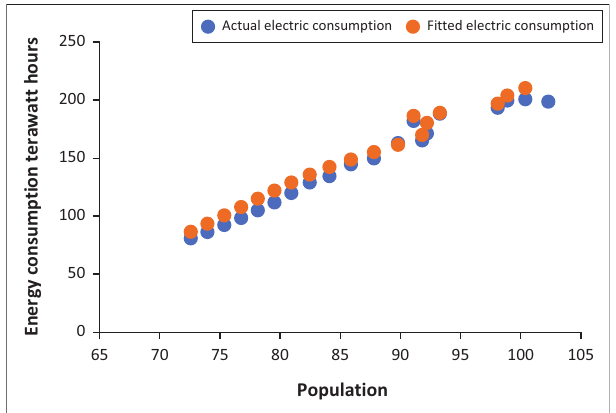
FIGURE 2: Regression of the electric energy